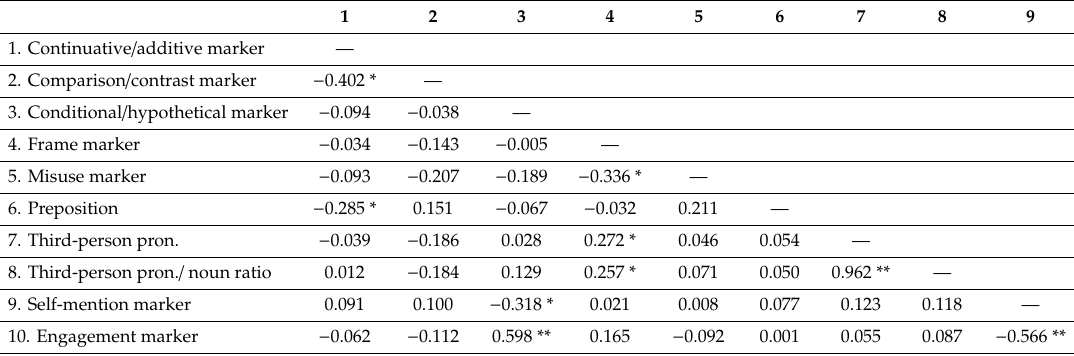
Table 6. Correlations among textual organizational measures ( n =